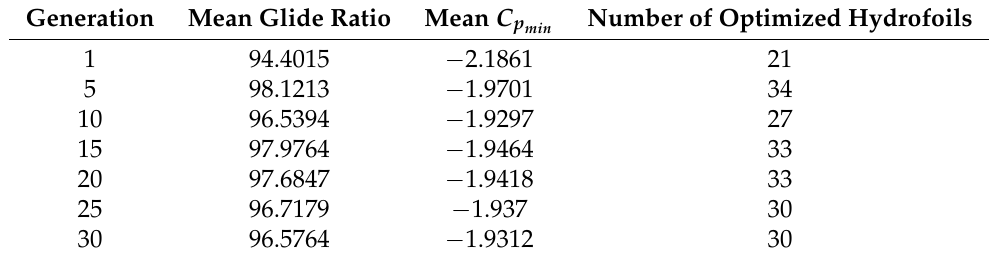
Table 2. Comparison of optimization results at different generations in the first case of 2D optimization.